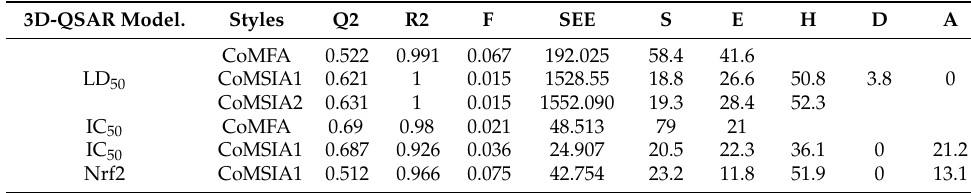
Table 2. 3D-QSAR models’ parameters. 3D-QSAR